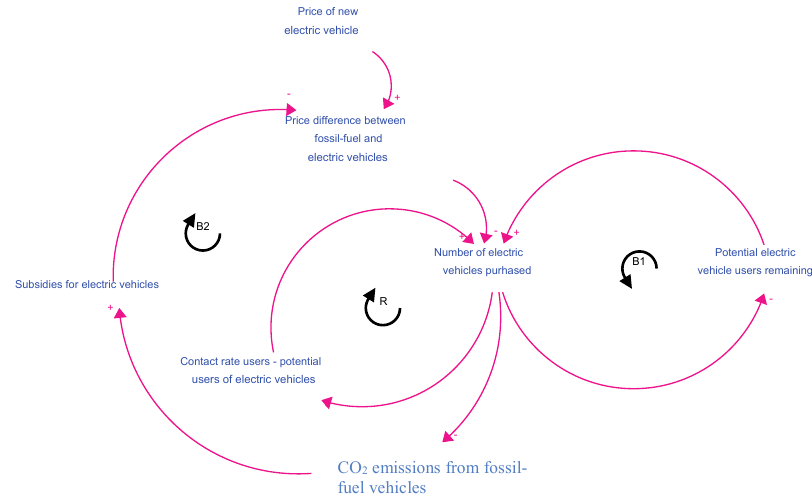
Fig. 1. Causal loop diagram (CLD) of the model. ‘Plus sign’ means that an increase/decrease in a cause results in an increase/decrease in effect relative to what otherwise would have been if everything else remains the same. ‘ Minus sign ’ means that an increase/decrease in the cause results in a decrease/increase in the effect relative to what otherwise would have been if everything else remains the